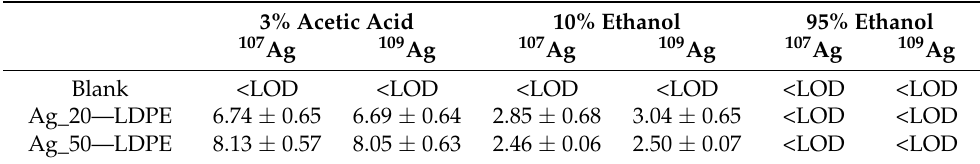
Table 1. Results of the silver release (measured as 107 Ag and 109 Ag) from different films into three food simulants by inductively coupled plasma-mass spectrometry (ICP-MS). Values are mean ± standard deviation (in µ